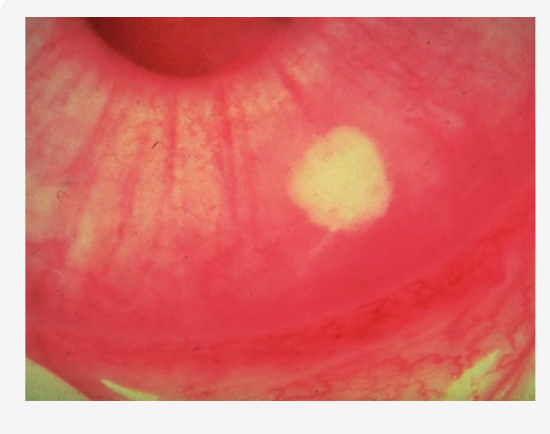
Figure 1. Polymer Pellet with Growth Factor in Cornea at time 0 days.